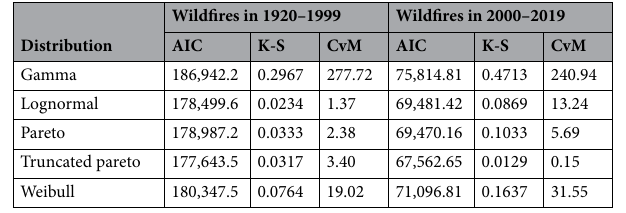
Table 2. Goodness-of-fit test results of Akaike Information Criterion (AIC), Kolmogorov–Smirnov (K–S) test, and Cramer-Von Mises (CvM) test for heavy-tailed distribution fitting.